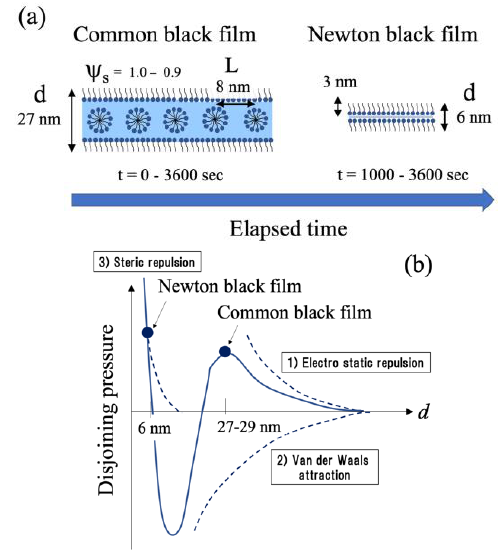
Figure 20. ( a ) Schematic summary of microstructures of collapsing foam film, as determined by time-resolved SANS measurements. The film thickness is d = 27 – 29 nm, and the volume fraction of the surfactant is ψ s = 0.1 – 0.05. The micelles, which are identical to those in the solution before foaming, exist in the film. For longer times (>1000 s), a Newton black film and a common black film coexist (thicknesses of d = 6 and 27 – 29 nm, respectively). ( b ) Schematic diagram showing the disjoining pressure (solid curve) as a function of the film thickness ( d ).